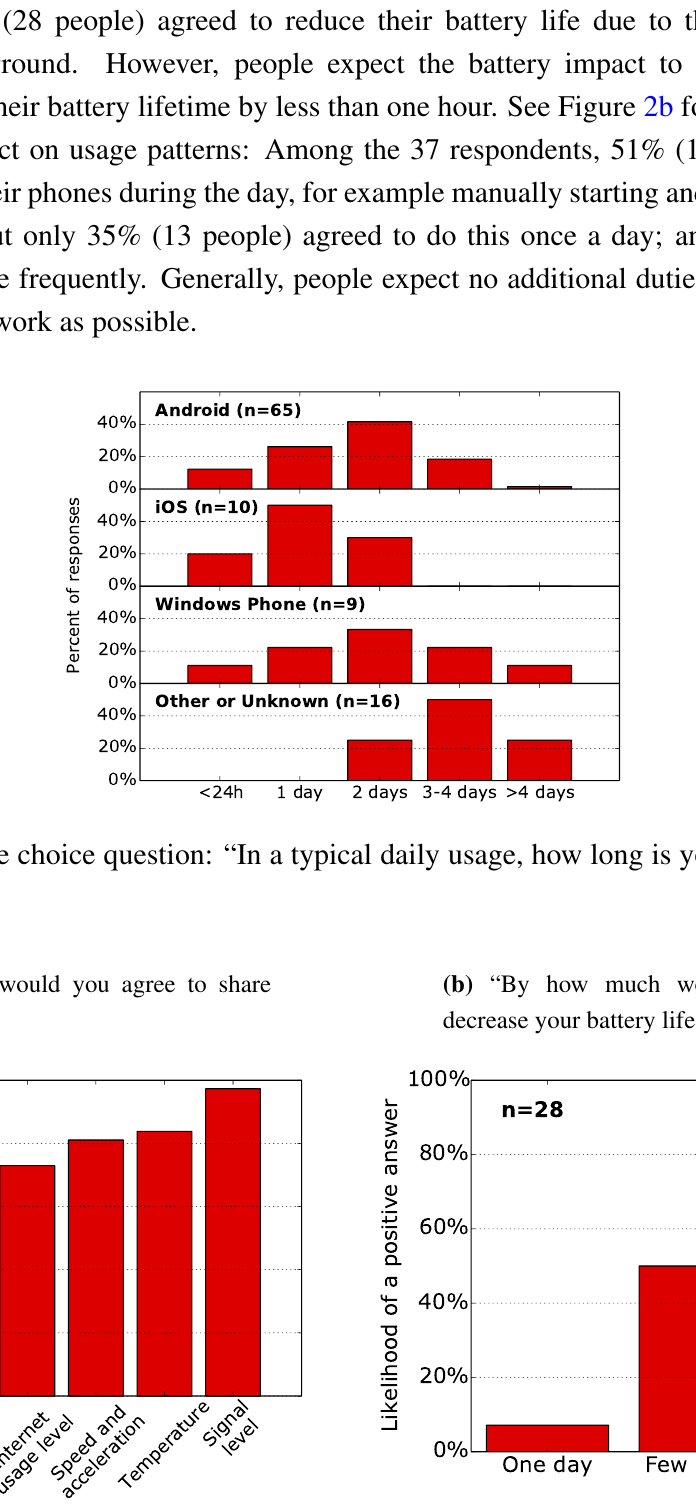
Figure 2. Multiple choice questions among: ( a ) respondents who agreed to participate in crowdsourcing; and ( b ) respondents who agreed to a shorter battery life due to data